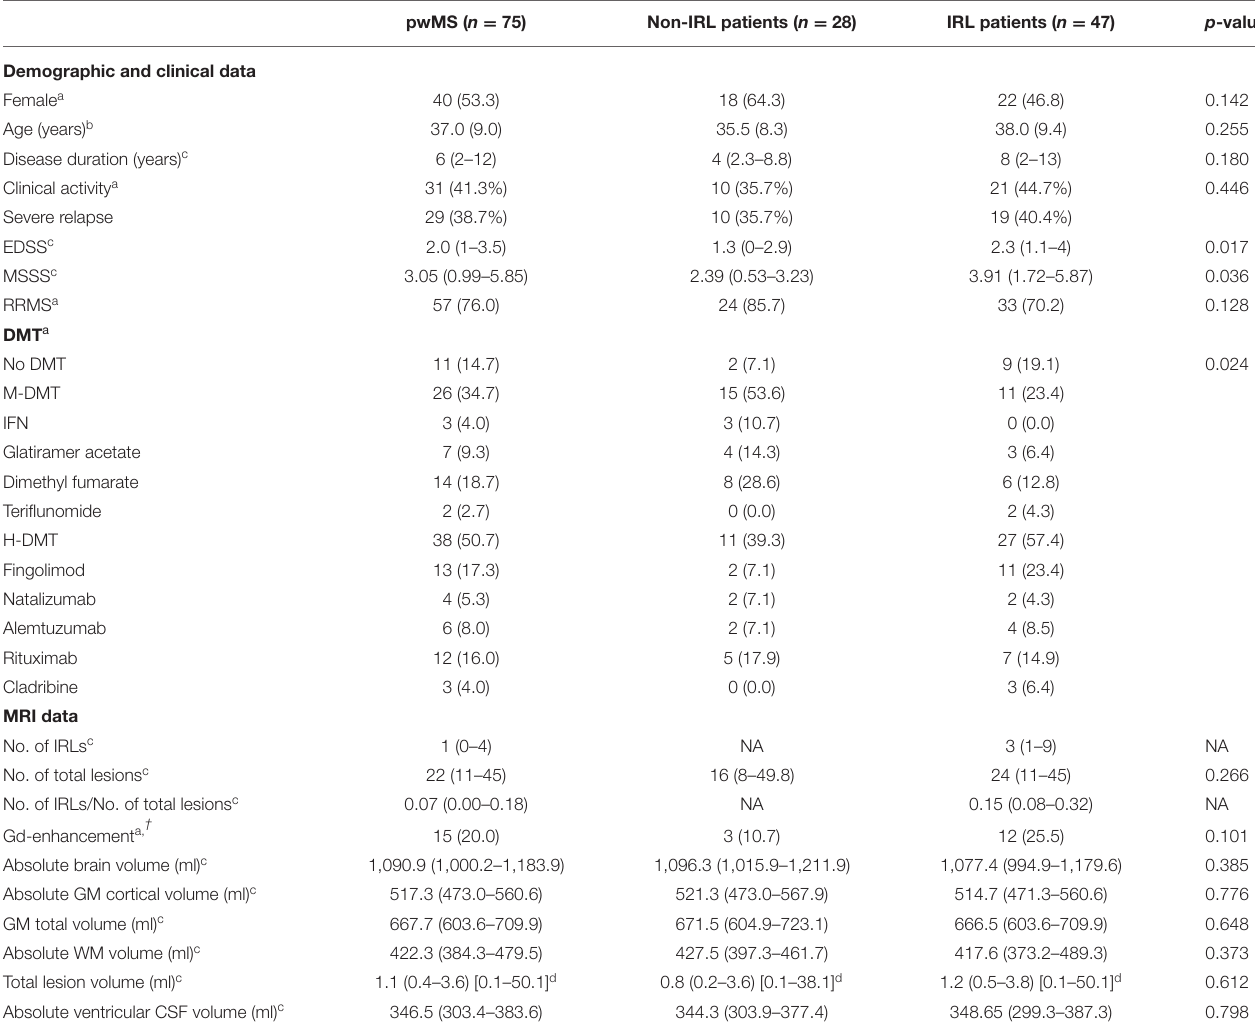
TABLE 1 | Characteristics of